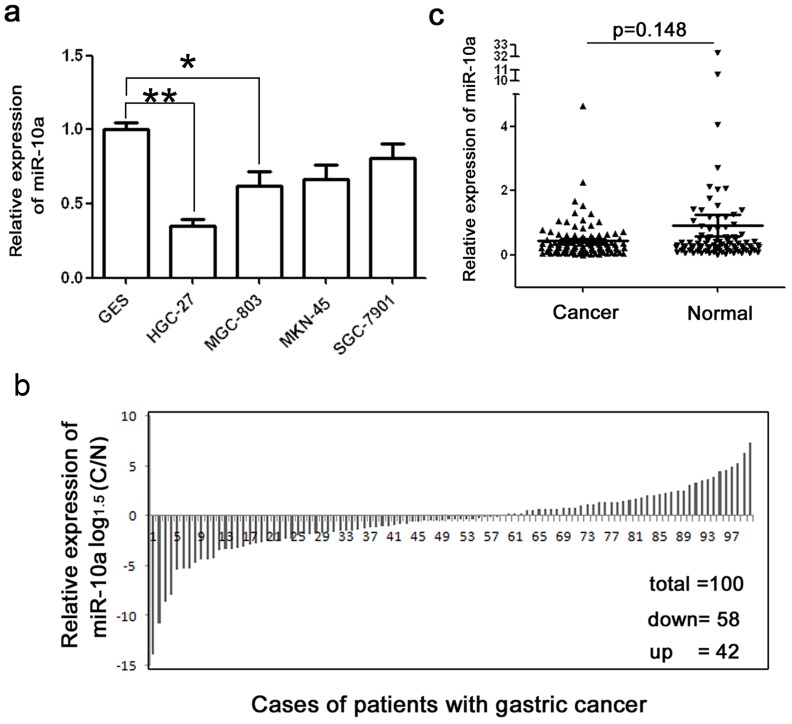
The expression of miR-10a in human gastric cancer cell lines and clinical GC samples.
a The expression of miR-10a in four human gastric cancer cell lines (HGC-27, MGC-803, SGC-7901 and MKN-45) and a human gastric epithelium cell line (GES) was detected using real-time PCR with TaqMan probes. b The expression of miR-10a in 100 pairs of GC tissues compared with their matched adjacent non-neoplastic tissues. c The expression of miR-10a in the GC tissues was lower than that in adjacent tissues, although there were no statistically significant differences. P = 0.148, paired t-test, two-tailed. U6 snRNA was used as the endogenous control.